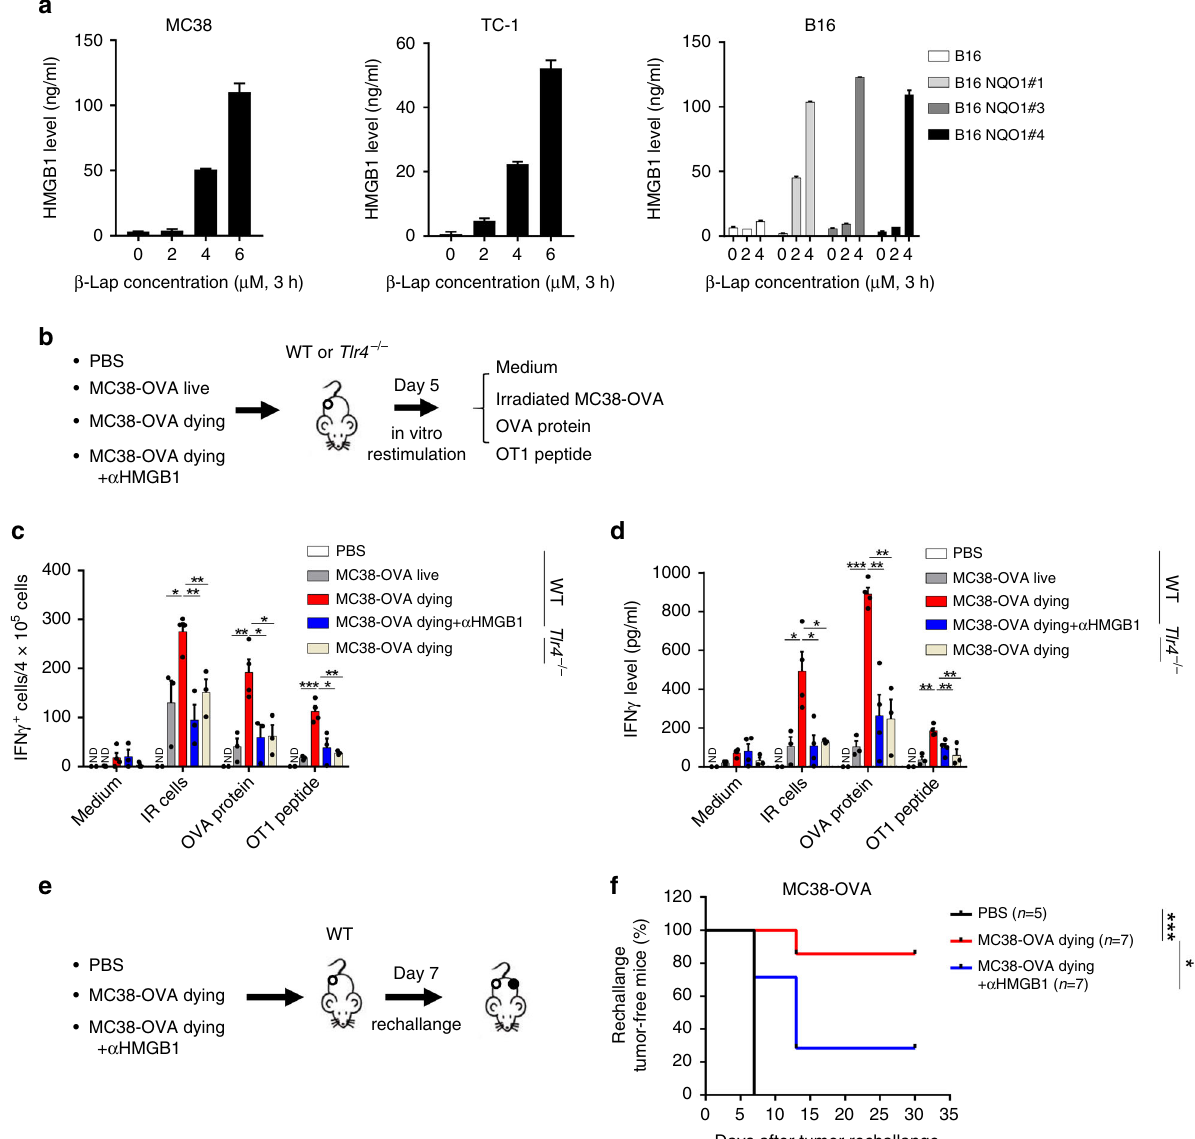
Fig. 5 β -Lap induces HMGB1-dependent immunogenic cell death. a MC38, TC-1, and B16 (NQO null and overexpression clones) were treated with β -lap for 3 h followed by washing and replacing medium. The level of HMGB1 released into the culture supernatant was determined by ELISA 24h later. b The research schema for in vivo cross-presentation of tumor-speci fi c antigen from β -lap-induced dying tumor cells in panels c and d . c , d Live or β -lap-induced dying MC38-OVA cells were subcutaneously inoculated into the fl ank of WT or Tlr4 − / − C57BL/6 mice ( n = 4 for MC38-OVA dying group; n = 3 for other groups) along with or without anti-HMGB1 antibody. Five days later, single-cell suspensions from tumor drain lymph nodes were collected and re- stimulated with OVA protein, OT-1 peptide, or irradiated MC38-OVA cells for 48 h. IFN γ -producing cells were determined by ELISPOTs assay in c , and IFN γ secretion level was quanti fi ed by CBA mouse IFN γ assay in d . e The research schema for the immunogenic vaccine assay in f . f MC38-OVA cells treated with β -lap in vitro were inoculated s.c. along with or without anti-HMGB1 antibody into the fl ank of C57BL/6 mice ( n = 5 for PBS group; n = 7 for MC38-OVA dying and MC38-OVA dying + α HMGB1 groups). After 7 days, mice were rechallenged with live MC38-OVA cells by injection into the contralateral fl ank. The percentage of rechallenged tumor-free mice was shown. Data are shown as mean ± SEM from three independent experiments. * p < 0.05, ** p < 0.01, and *** p < 0.001 determined by two-way ANOVA ( c , d ) or log-rank test in